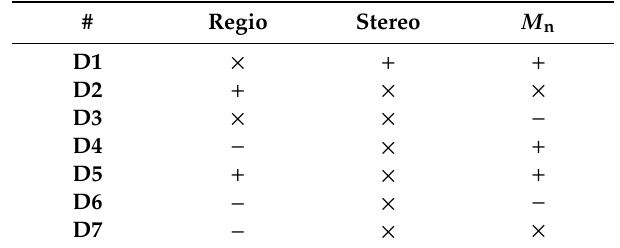
Table 7. List of used descriptors and their impact in the QSAR models for stereoselectivity, regioselectivity, and polymer molar mass